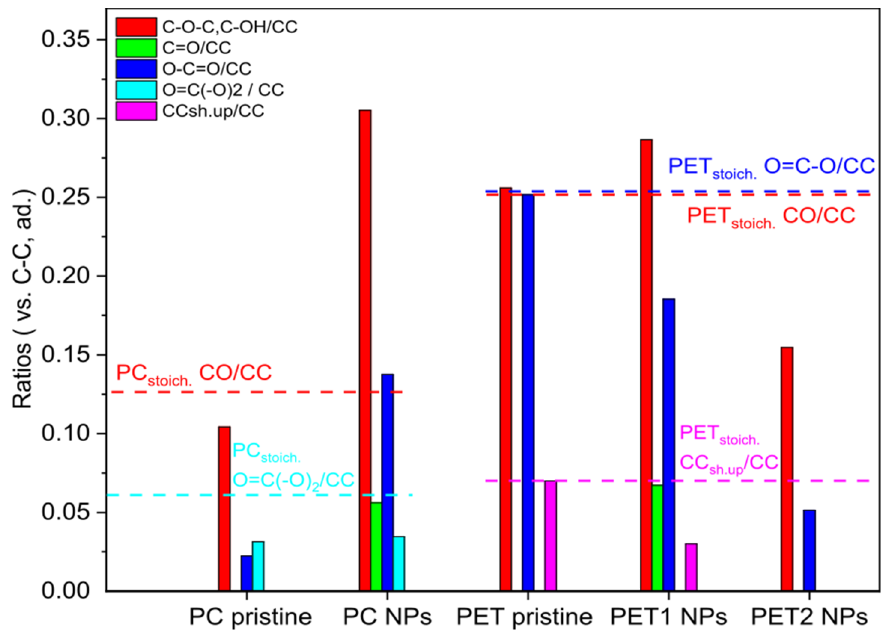
Figure 2. Atomic bonding distribution from XPS C1s spectra analysis. High-resolution spectra curve-fit results from the laser ablated and PET2 NPs. Dotted lines represent stoichiometric reference values.